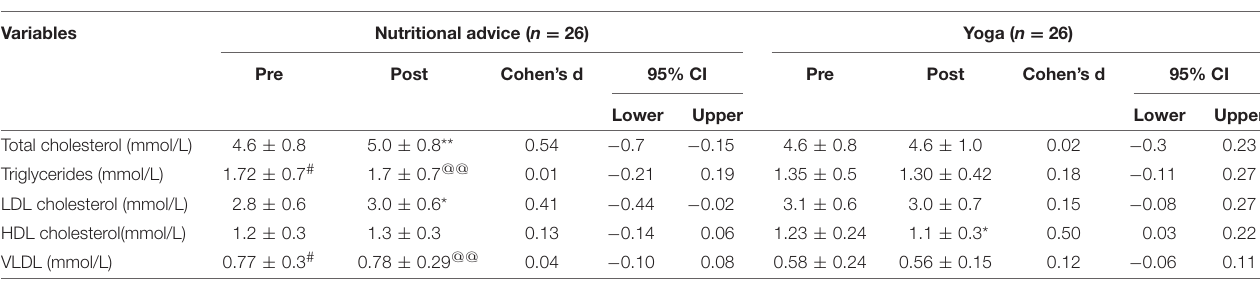
TABLE 4 | Lipid profile. Variables Nutritional advice ( n = 26)